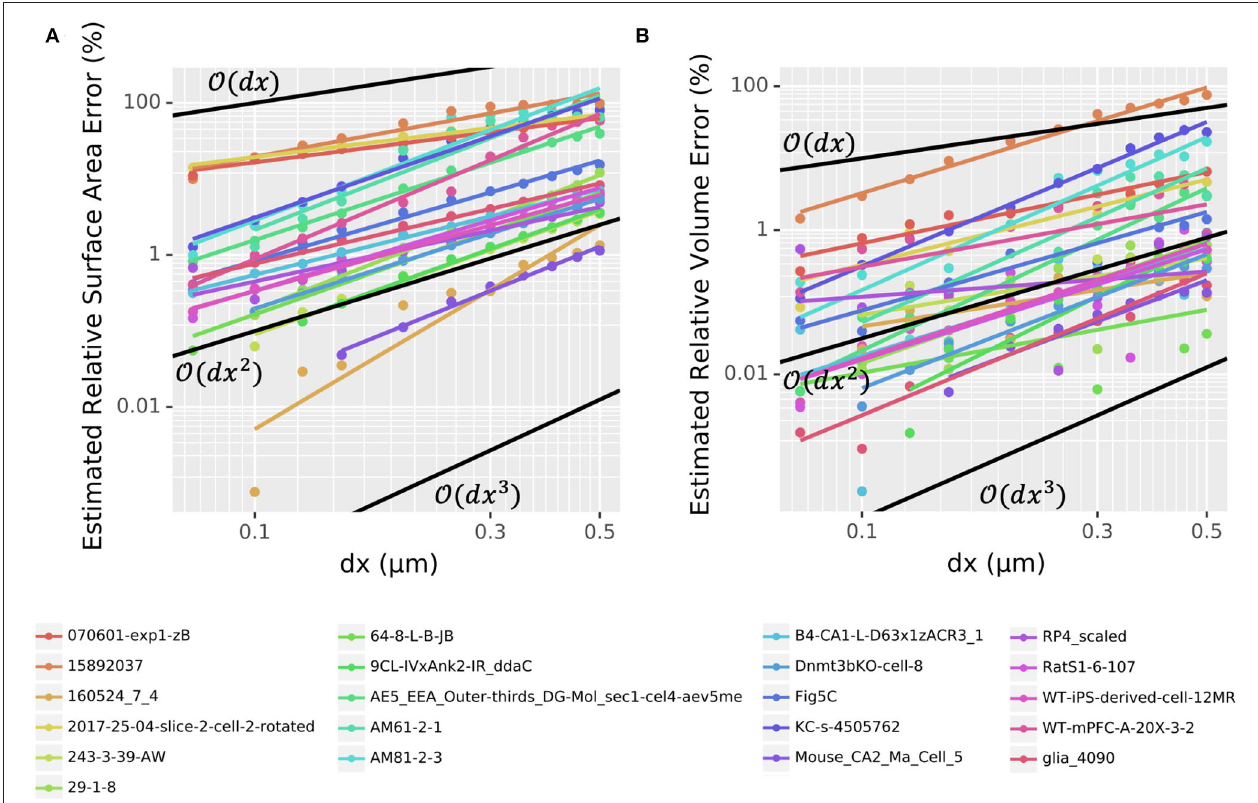
FIGURE 2 | Log-log plots of estimated (A) surface area and (B) volume relative error as a function of dx for the voxelization of 21 entire morphologies (all sections) chosen randomly from NeuroMorpho.Org. Points indicate measured values; colored lines indicate best-fits. Black lines indicate first-, second-, and third-order convergence, as marked, for reference. Note that the y -axis scale is different between (A) and (B)